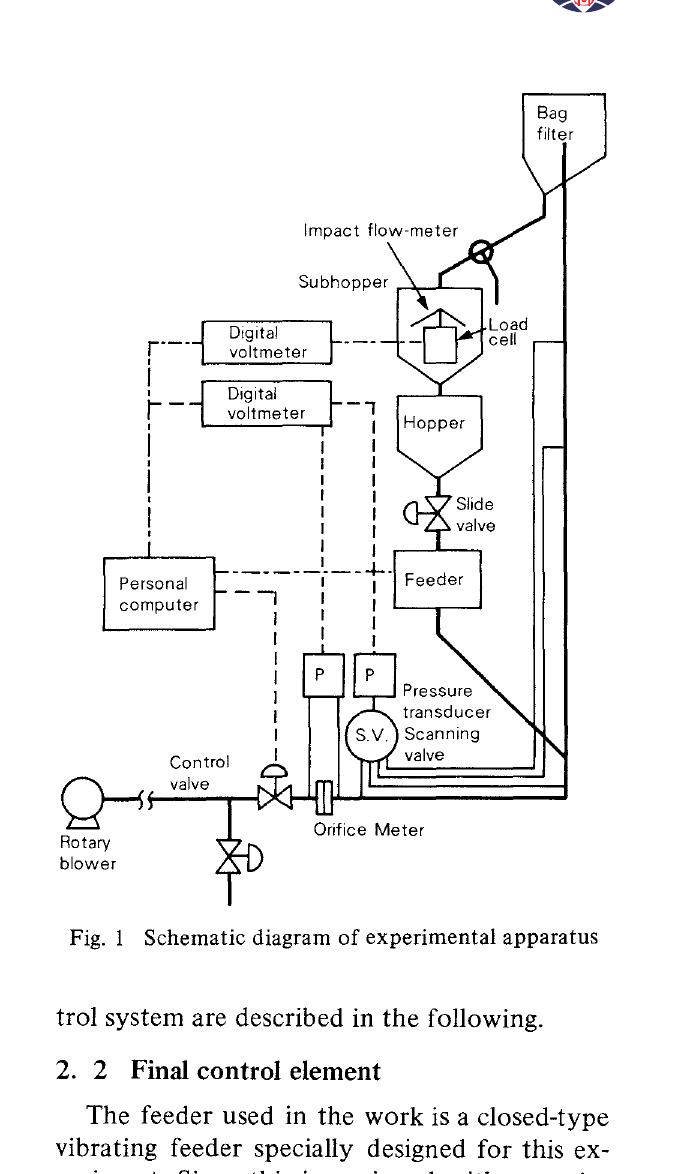
Fig. 1 Schematic diagram of experimental